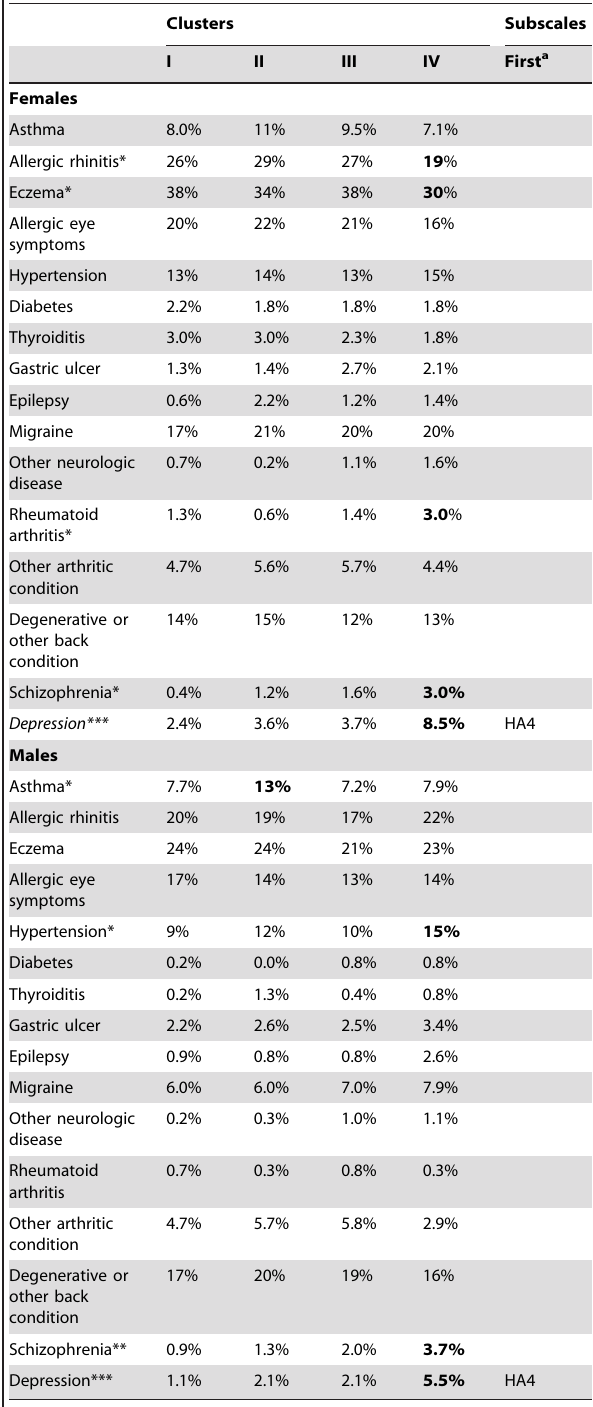
Table 4. Confirmed diagnoses.